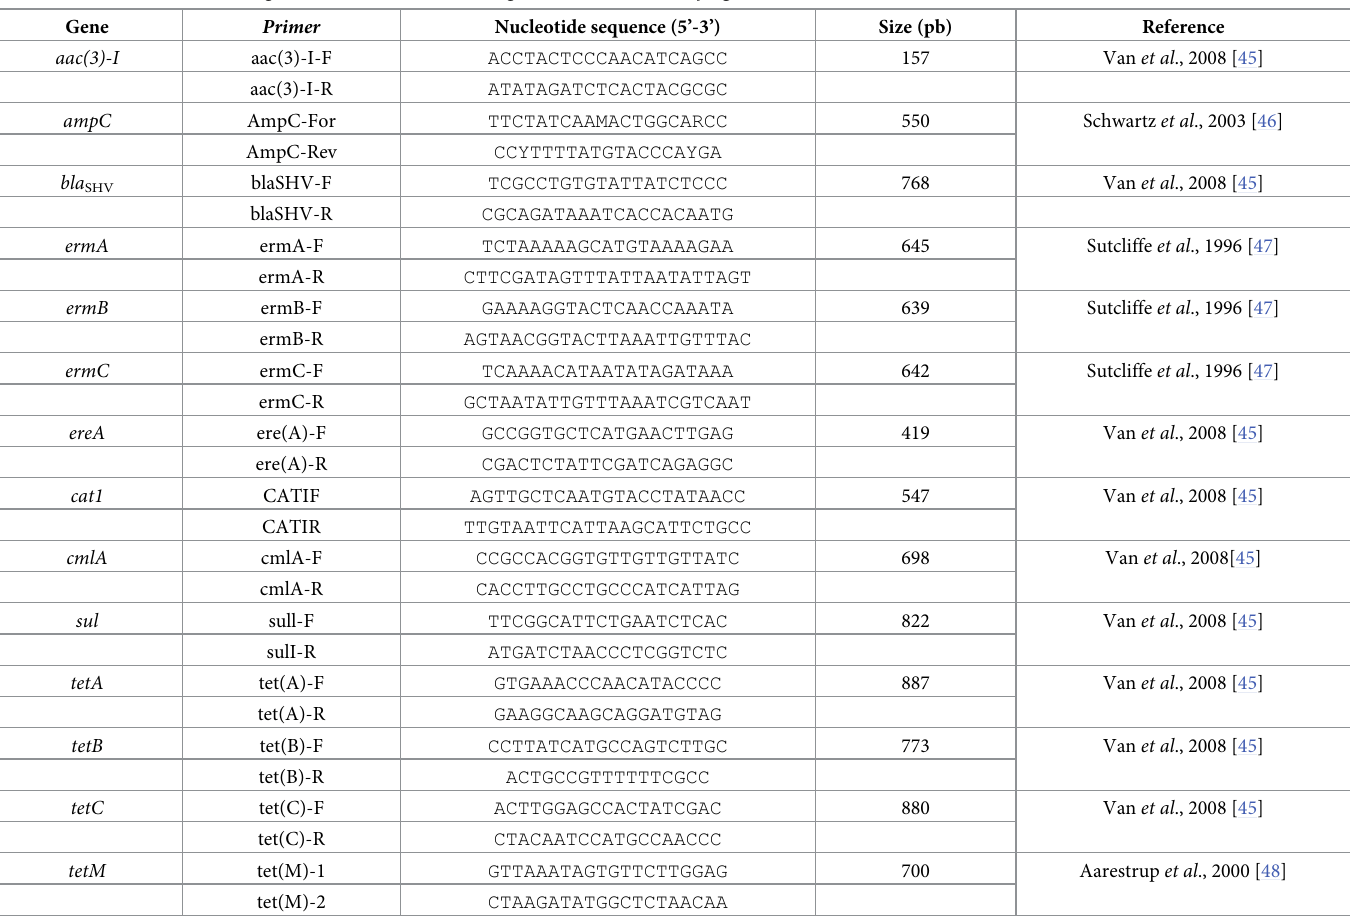
Table 1. Primers used to investigate antimicrobial resistance genes in Listeria monocytogenes